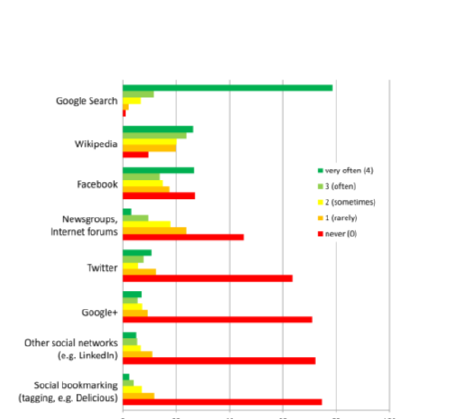
Figure 11. Valid percentage of students’ responses